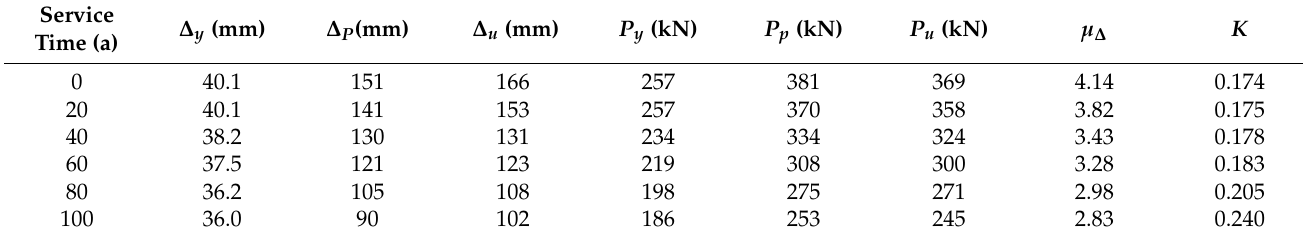
Table 3. Strength, ductility and stiffness of the HRC bridge columns with different service time.